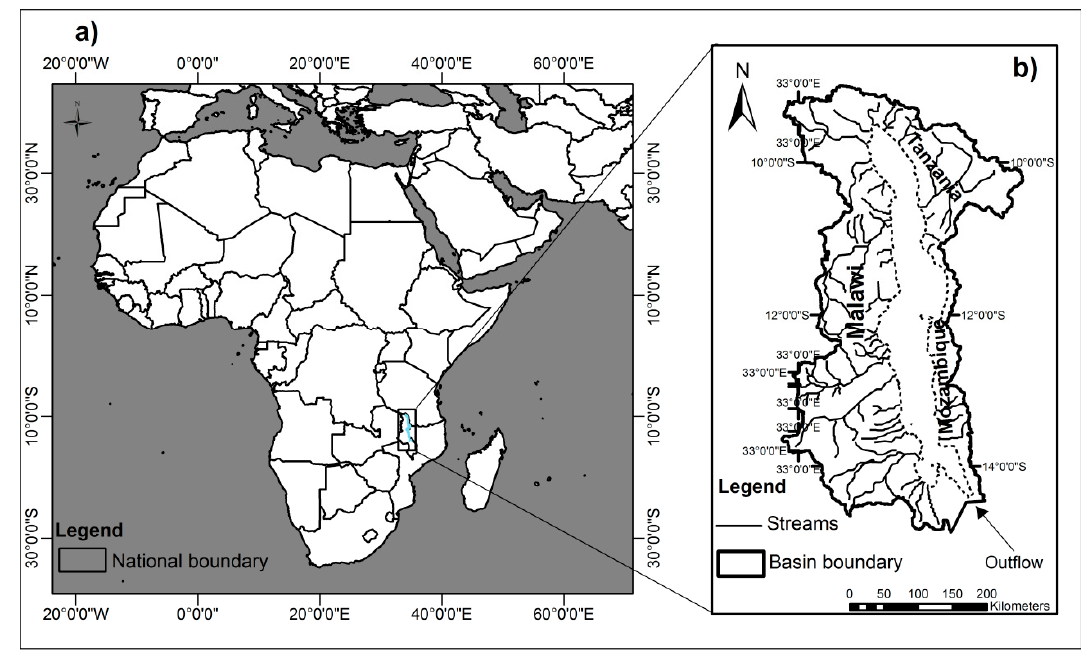
Figure 1. Location of Lake Malawi and its watershed; the lake includs 13 main inflows and only 1 outflow (modified from [4]) ( a ) Geographical location of Lake Malawi ( b ) Lake Malawi basin including its adjacent countries.